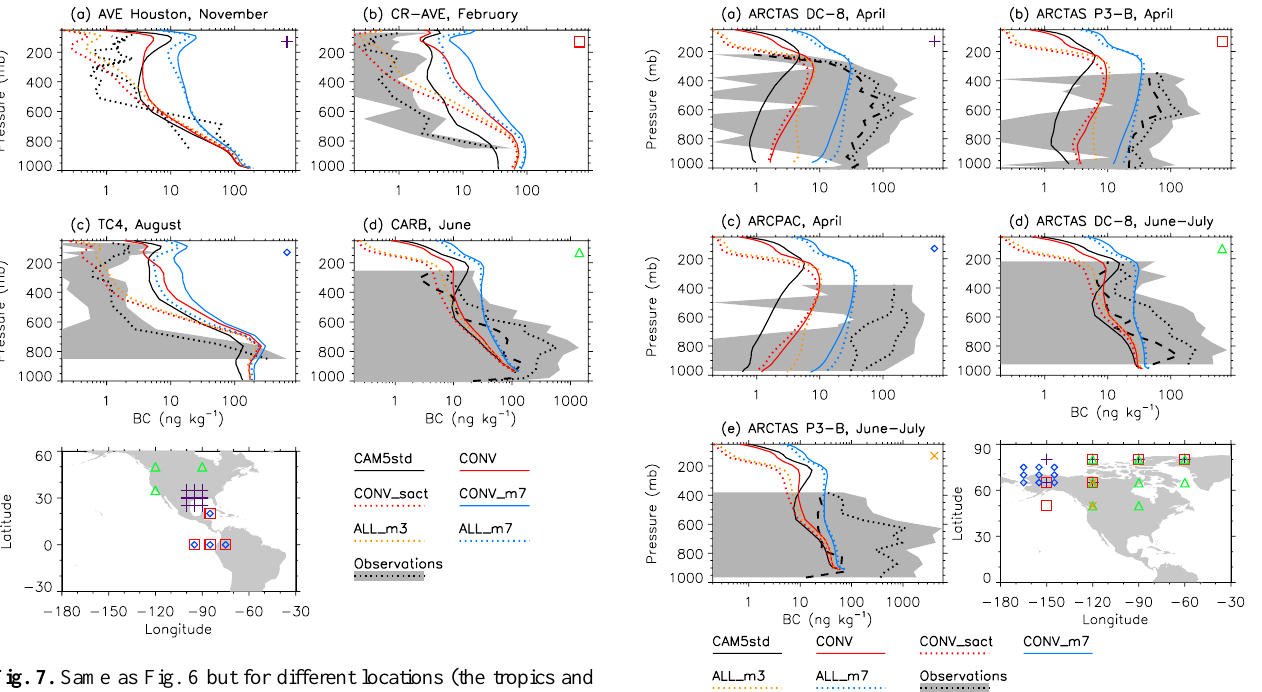
Fig. 7. Same as Fig. 6 but for different locations (the tropics and mid-latitudes) and months. Black dashed line (if present) is the me- dian profile of observed BC (ngkg − 1 ) . In (a) the two black dotted lines are for two sampling days. Biomass burning was encountered in (d) . Symbols over the map in the bottom panel indicate the ap- proximate geographical location of the observed profiles for each field campaign, and simulated profiles represent averages over these locations. More information about the observations is available in Koch et al. (2009b; Fig. 9 and Table 7).